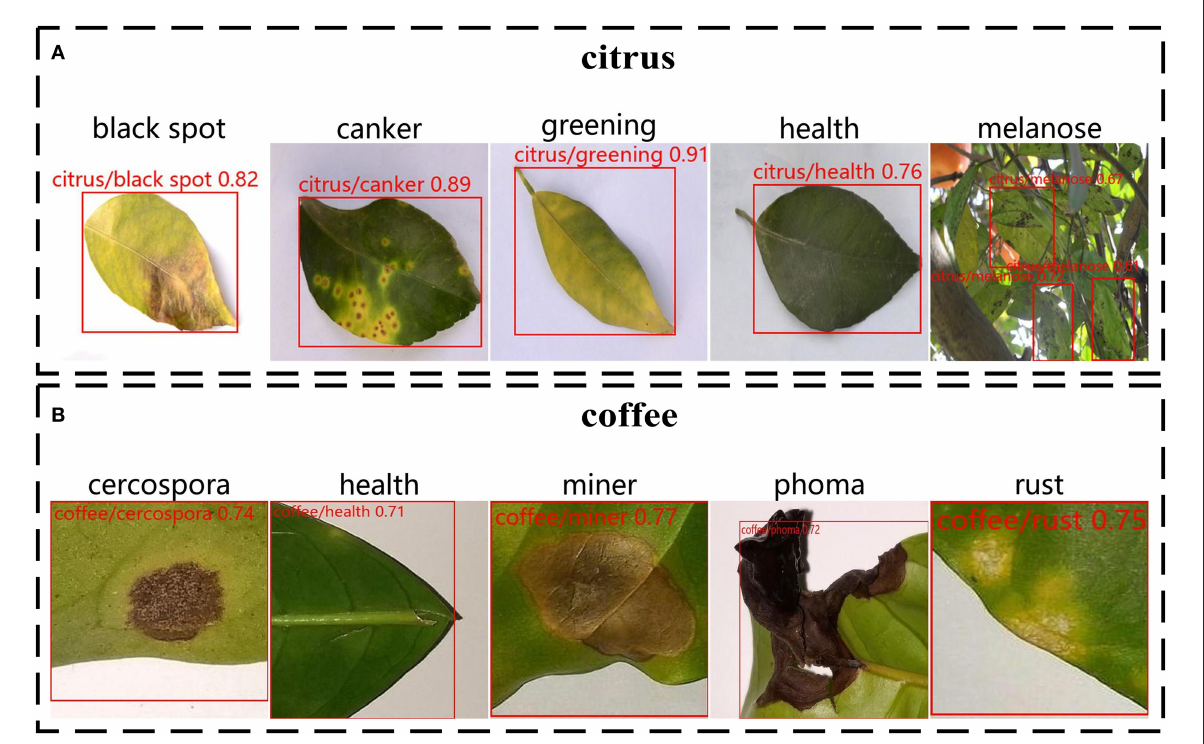
FIGURE8 An identification example of open-set identification on citrus datasets and coffee datasets. The red zone in the diagram indicates a leaf location. The description text on each image indicates the type of disease and the confidence of recognition. (A) Recognition results of diseases on citrus leaf images. (B) Recognition results of diseases on coffee leaf